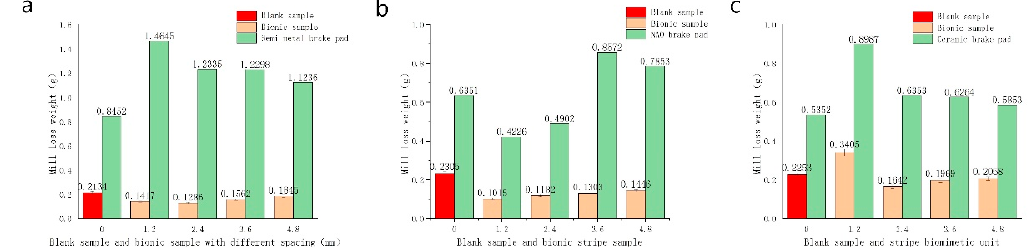
Figure 11. Wear result diagram of interactions between the striped bionic unit sample and three kinds of brake pads. ( a ) The wear of bionic samples and semi-metallic brake ads; ( b ) the wear of bionic samples and organic asbestos-free (NAO) brake pads; ( c ) the wear of bionic samples and ceramic brake pads.